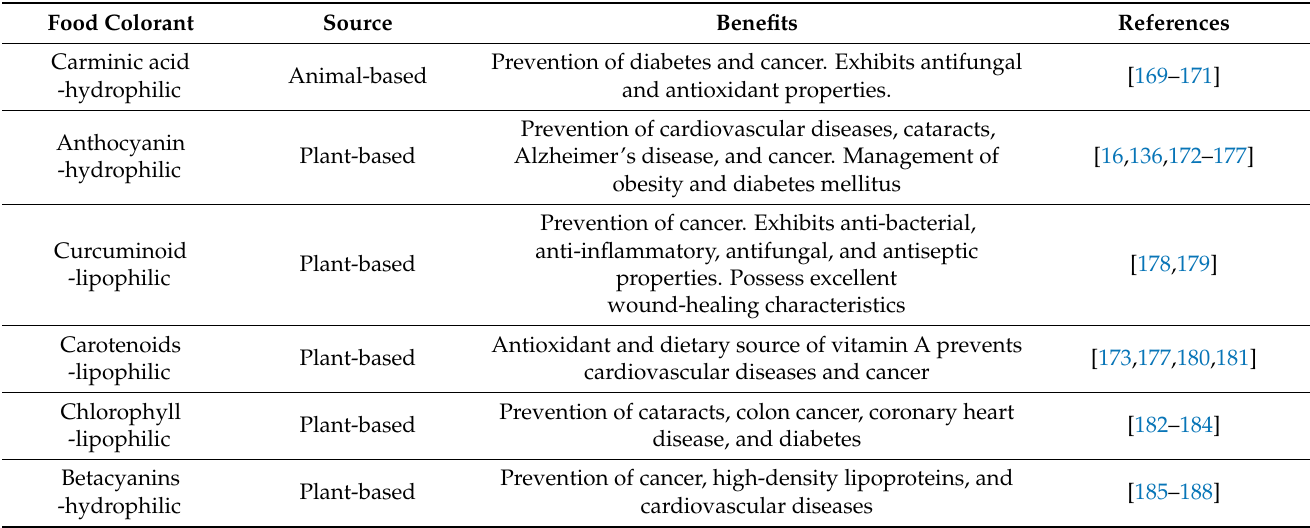
Table 4. Some of the natural food colorants, their sources, along with their beneficial